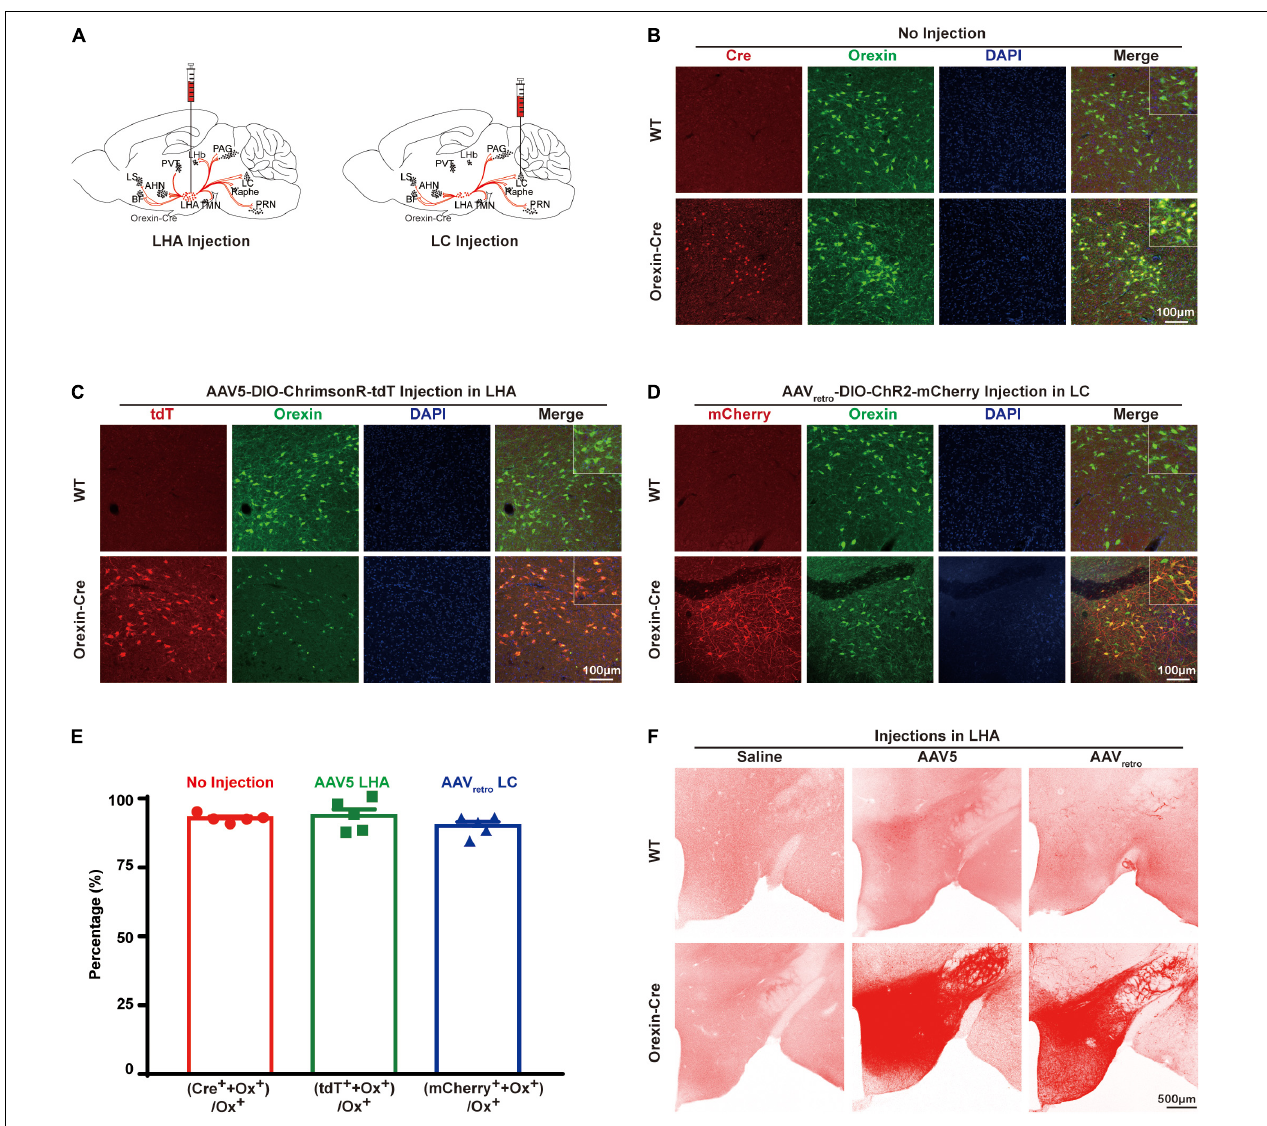
FIGURE 1 | Opsin expression in the orexin-Cre mouse brain. (A) Schematic diagrams illustrate AAV virus injections into the orexin-Cre mouse brain. (B) Immunostaining of Cre (red), orexin (green), and DAPI (blue) in brain slices showed an overlapping expression of Cre and orexin in only orexin-Cre mice but not wildtype (WT) mice. (C,D) To express opsin in orexin neurons, orexin-Cre or WT mice received injections of AAV5-DIO-ChrimsonR-tdT into the LHA (C) and AAVretro-DIO-ChR2-mCherry into the LC (D) , and the brain slices were stained for mCherry (red), orexin (green), and DAPI (blue). The result showed expression of ChrimsonR-tdT and ChR2-mCherry in orexin neurons in orexin-Cre mouse but not WT mouse. (E) Quantitative analysis showed 92.87 ± 0.6974% ( n = 5) colocalization of Cre recombinase with orexin in no-injection group, 93.7 ± 2.456% ( n = 5) colocalization of tdTomato with orexin in AAV5 group, and 90.07 ± 1.593 % ( n = 5) colocalization of mCherry with orexin in AAVretro group. (F) To compare the expression levels from different AAV serotypes, expressions in hypothalamus from saline, AAV5-DIO-ChrimsonR-tdT, and AAVretro-DIO-ChR2-mCherry injections in the WT or orexin-Cre mice are shown. AHN, anterior hypothalamus nucleus; BF, basal forebrain; LC, locus coeruleus; LHA, lateral hypothalamus area; LHb, lateral habenula; LS, lateral septum; PAG, periaqueductal gray; PVT, paraventricular nucleus of the thalamus; PRN, pontine reticular nucleus, TMN, tuberomammillary